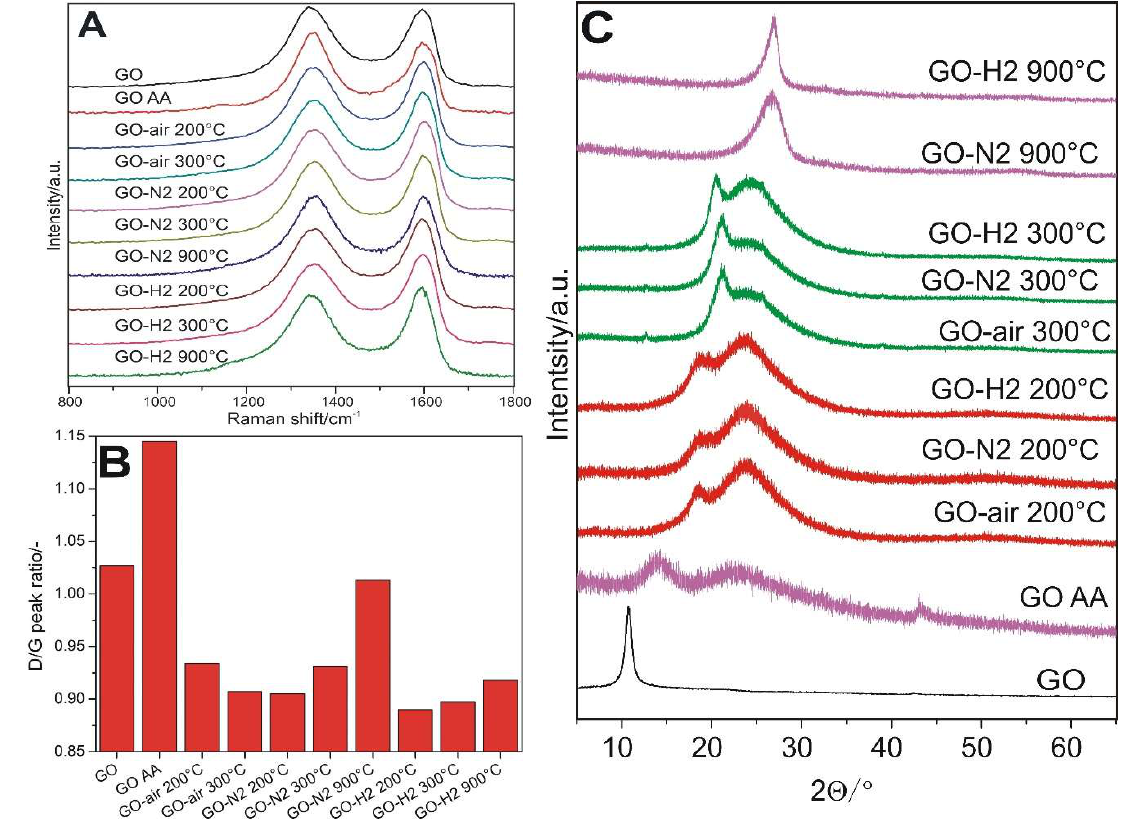
Figure 7. Raman spectra ( A ), the intensity ratios of the carbon D/G peaks ( B ) and the XRD diffractograms ( C ) for the samples.